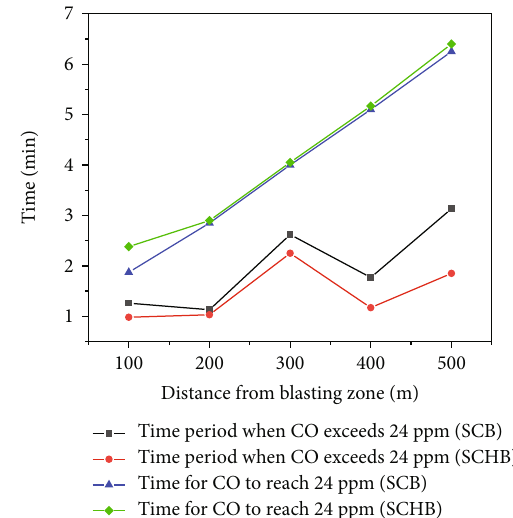
Figure 14: Time taken by CO to reach 24 ppm and exceed the same along the monitoring distance in single-hole SCB and